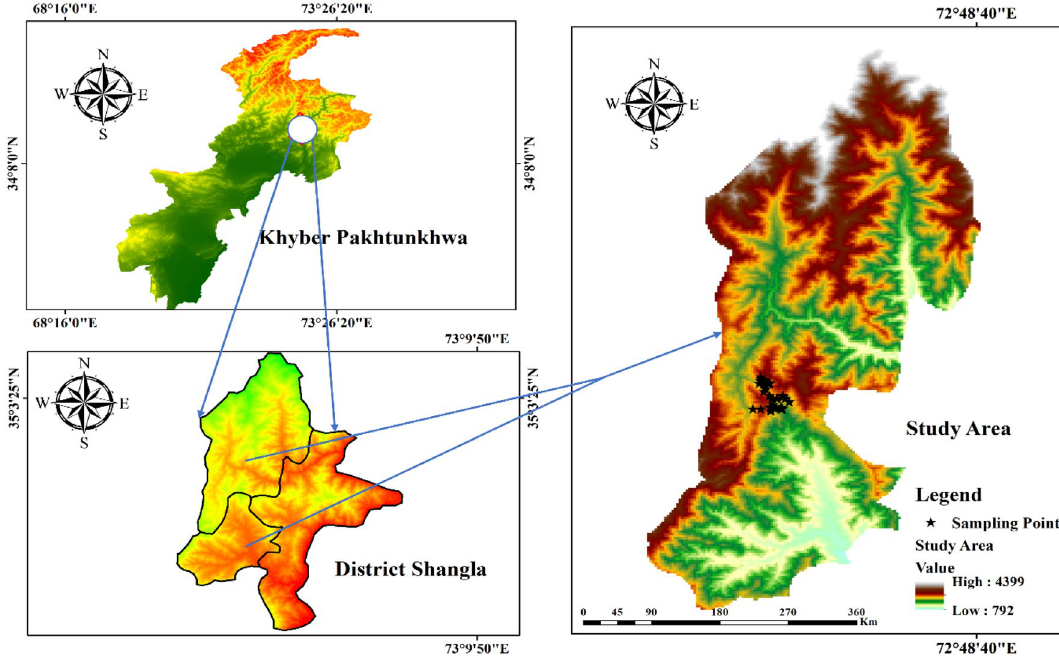
Figure 1. GIS generated map of the study area representing the sampling localities 56